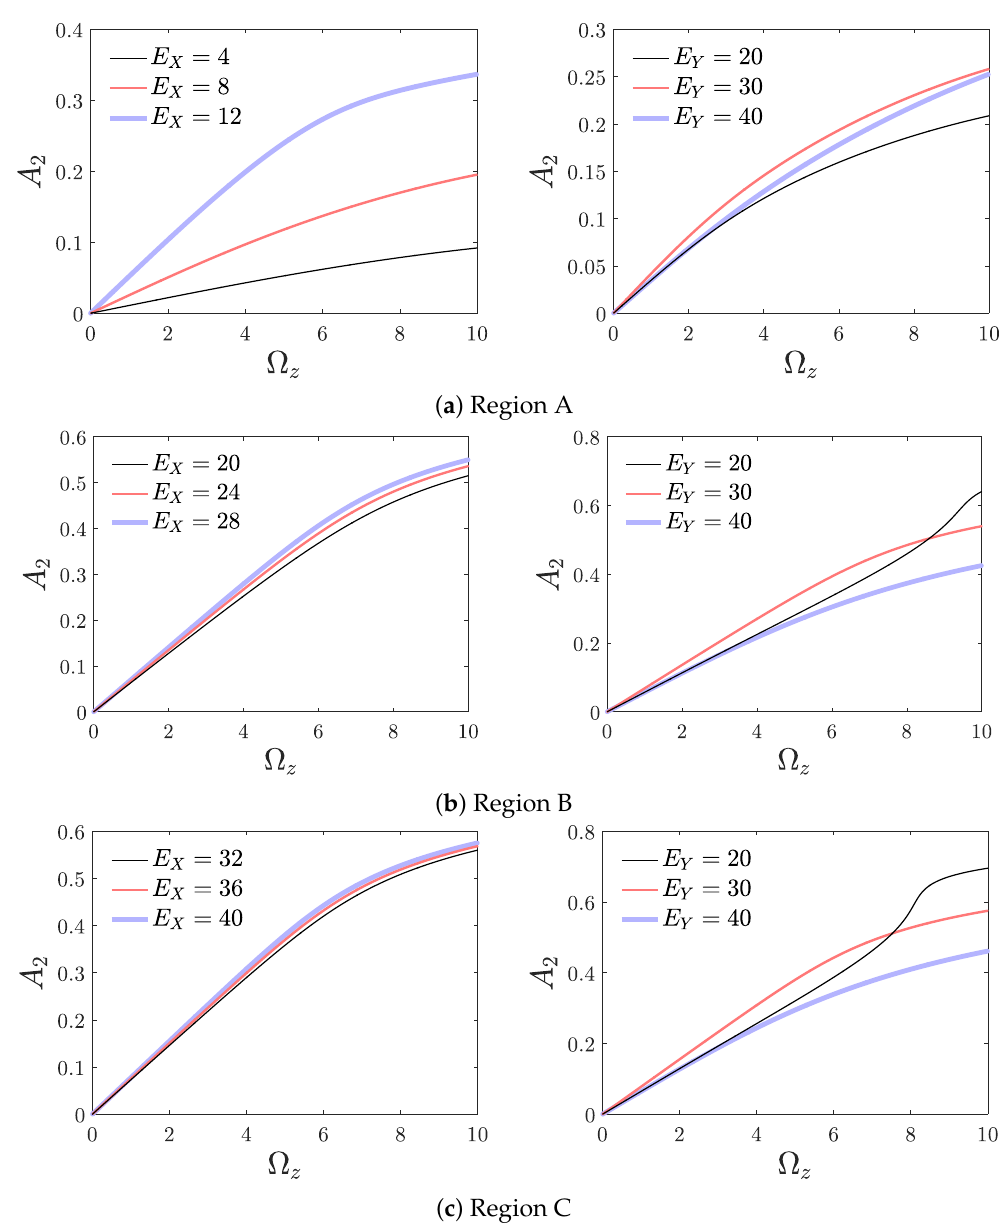
Figure 12. Variations in the detecting amplitude with the measured angular velocity corresponding to different parameter regions; Region A: E X = 10, E Y = 30, Region B: E X = 25, E Y = 30, and Region C: E X = 40, E Y =